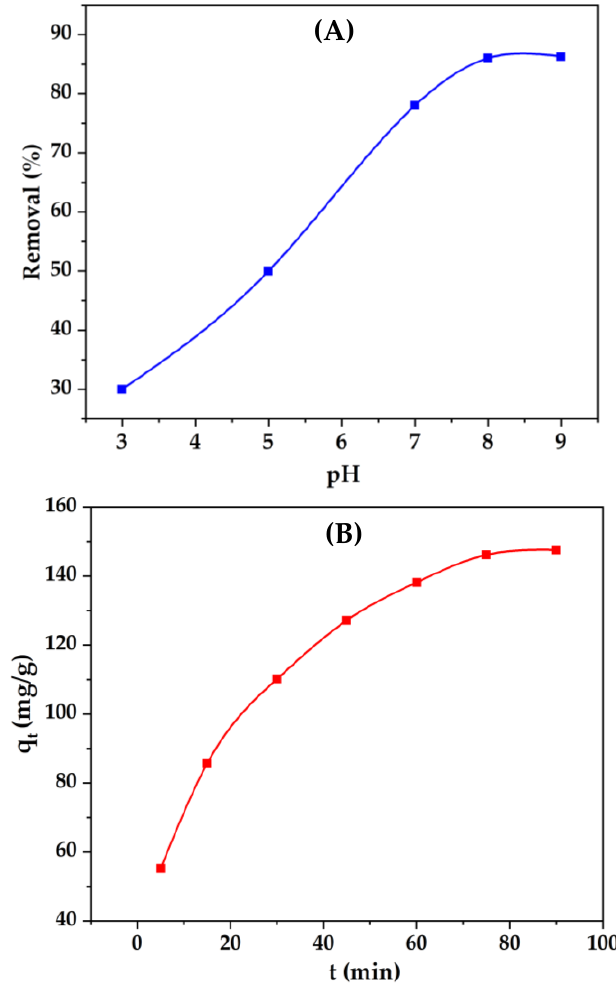
Figure 3. The influences of ( A ) pH and ( B ) time on removal (%) of MB by BGS-derived biochar.